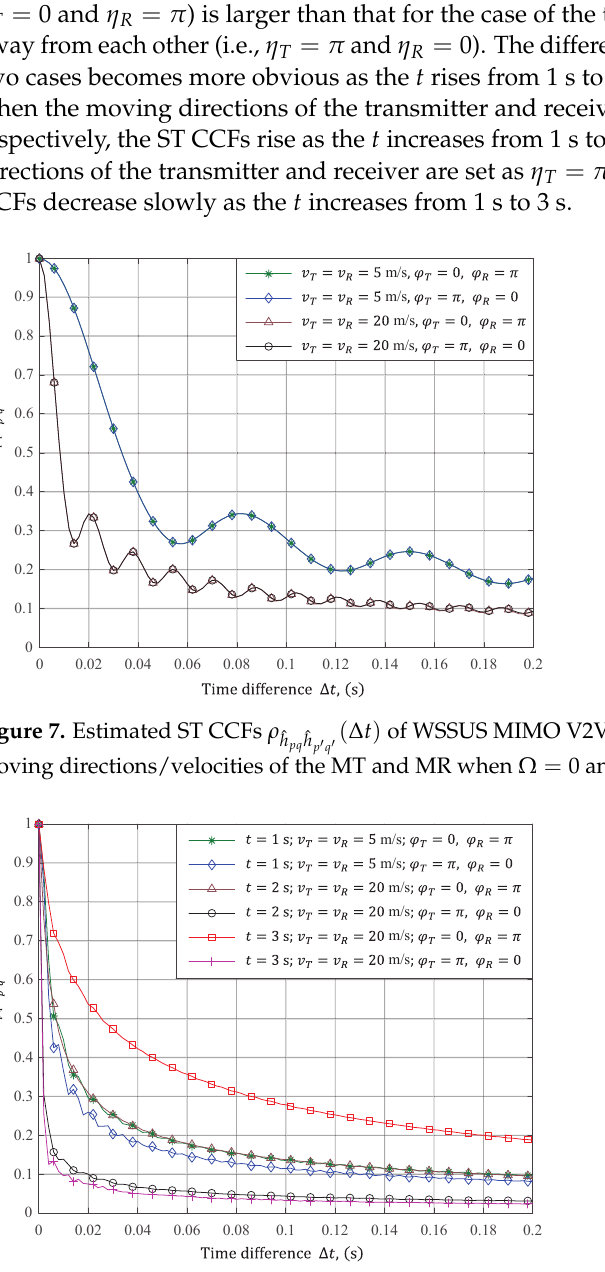
( t , ∆ t ) of WSSUS MIMO V2V channel model with respect to the Figure 8. Estimated ST CCFs ρ ˆ h pq ˆ h p (cid:48) q (cid:48) moving directions/velocities of the MT and MR when Ω = 0 and D 0 = 100